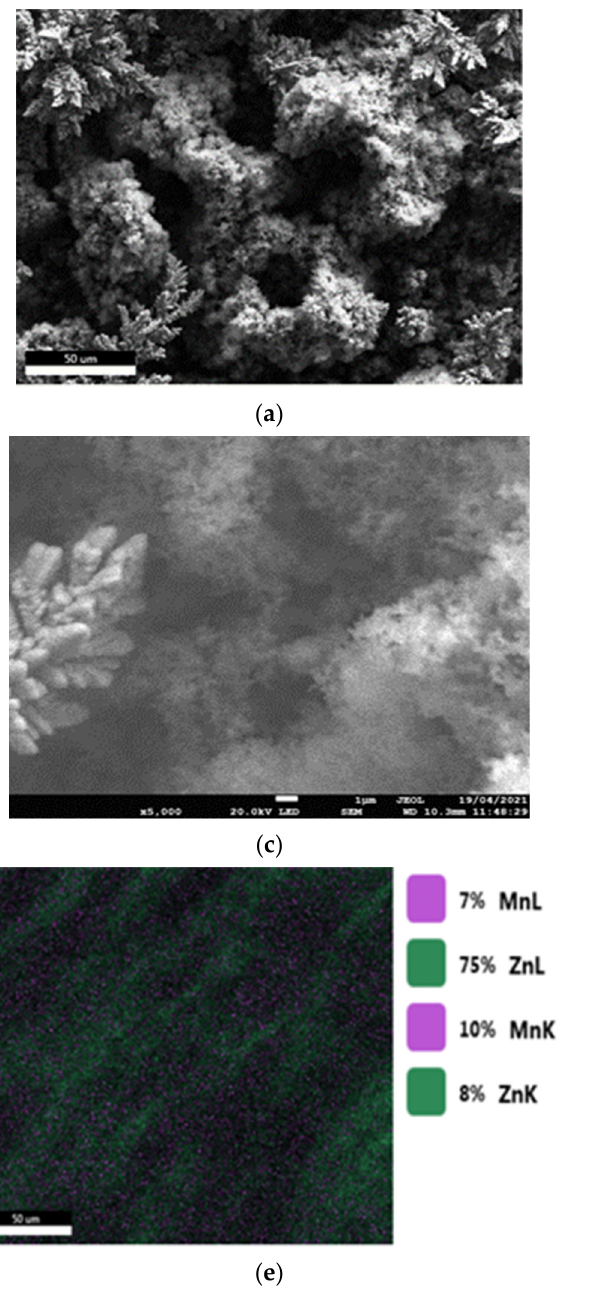
Figure 11. Morphologies of coatings elaborated for B = 0 T and for E = -1.8 V/SCE, before immersion (( a ) imagex500, ( b ) mapping, and ( c ) imagex5000 and after immersion for 2 h in 35 g/L NaCl ( d ) imagex500, ( e ) mapping, and ( f ) imagex5000).